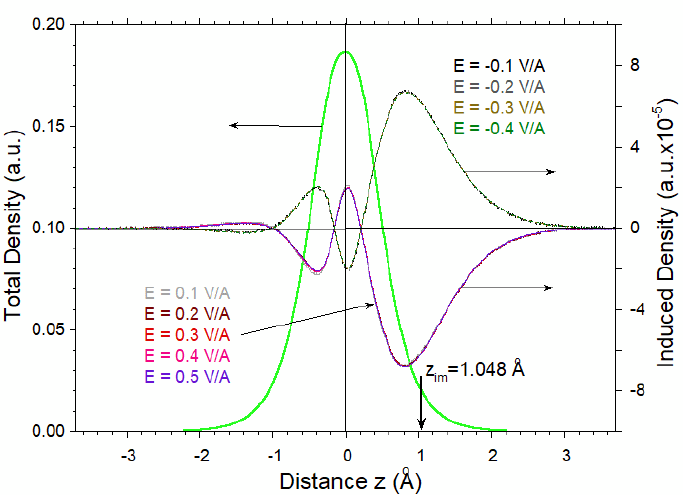
Figure 3. The valence charge density of graphene averaged in the x - y plane (green thick line) and induced charge densities generated by an applied electric field E for the color-coded values shown in the insets. The induced density for E = θ × 0.1 V/Å is normalized by the value of | θ | . The origin of the z direction is taken as the carbon atom position. The image plane position z im at 1.048 Å is marked by vertical arrow (the positive value is due to the application of the electric field from the right